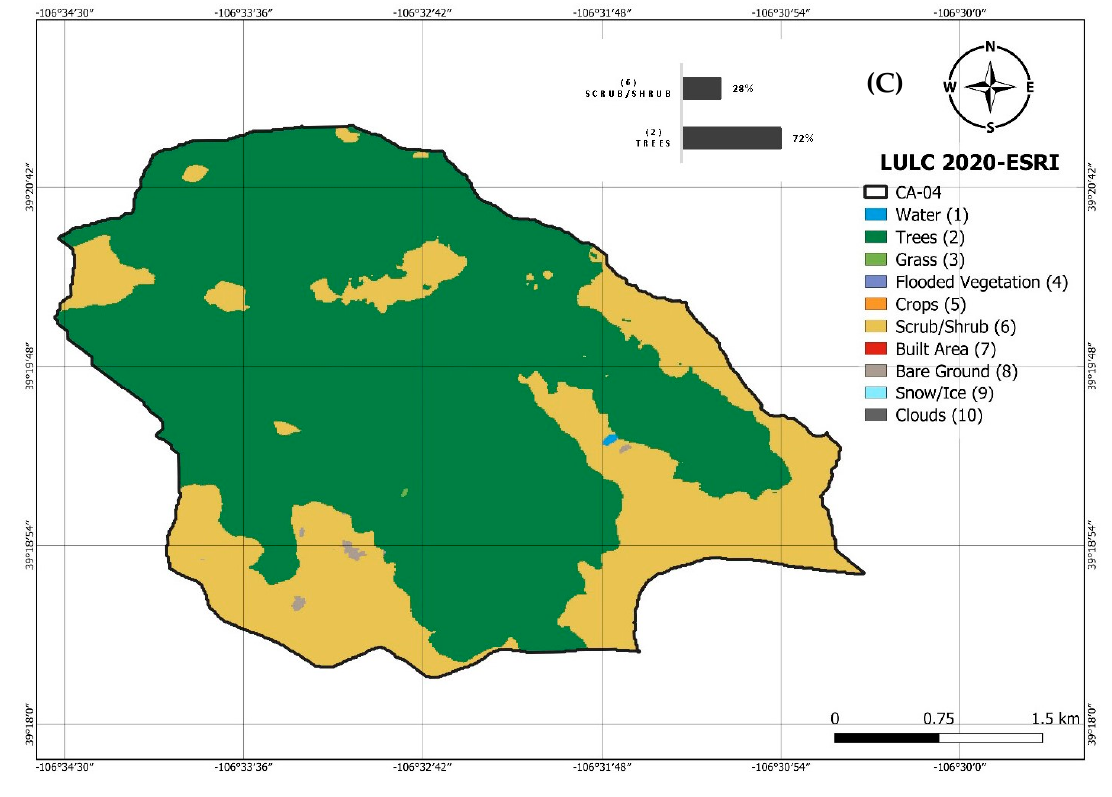
Figure A4. DEM and land-use maps for Catchment CA-04 ( A ) DEM, ( B ) NLCD 2019 land-use map, ( C ) LULC 2020-ESRI land-use map.